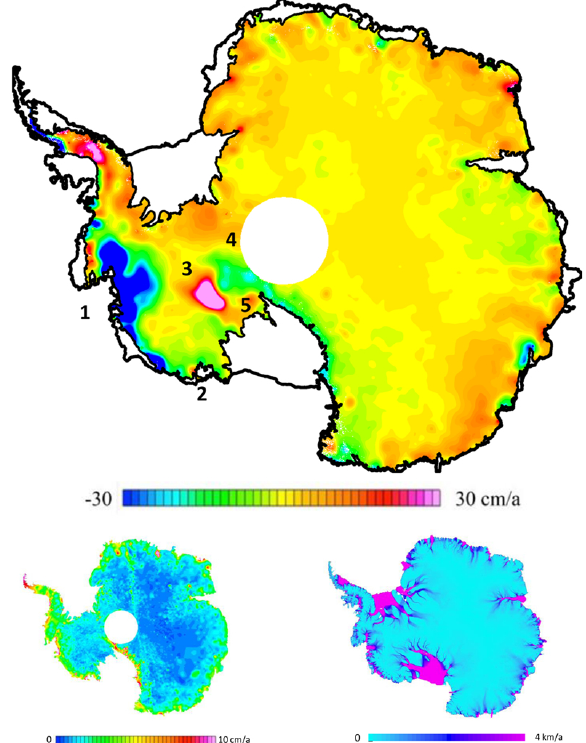
Figure 6. Upper panel: mean annual dynamic thickness change rate (March 1 2004 - February 28 2009). Numbers mark re- gions with distinct thickness change patterns described in the text. Lower panel: error of mean annual dynamic thickness change rate map (left) and ice velocity from InSAR measure- ments